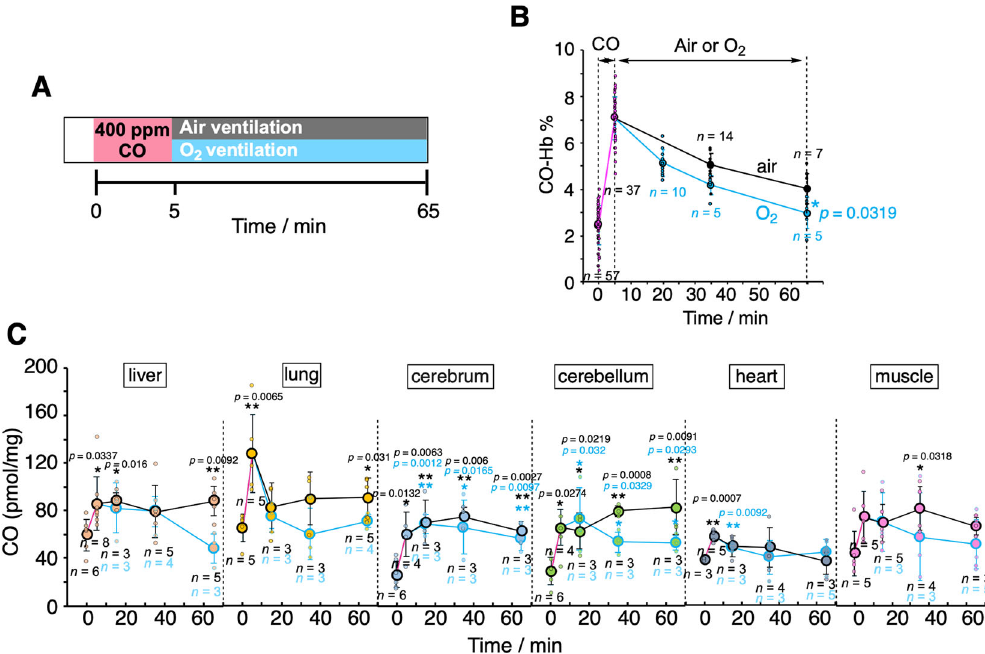
Fig. 6 Effect of normobaric air/O 2 ventilation on CO levels in blood and tissues after exposure to CO in rats. A Anesthetized rats were exposed to CO inhalation (400 ppm) for 5 min followed by either air (black) or O 2 ventilation (blue) as indicated. B Changes in CO-Hb (%) in the venous blood collected from right ventricles as a function of time. Each plot represents mean ± SD ( n > 5, the number of experiments is shown in the panel). Statistical signi fi cance, * p < 0.05, versus air ventilation. C Amounts of CO measured under the experimental conditions described in A . The plots connected by black and blue lines represent the data obtained under air and O 2 ventilation, respectively. Each bar represents mean ± SD ( n > 3, the number of experiments is shown in the panel). Statistical signi fi cance, * p < 0.05, ** p < 0.01; n.s. not signi fi cant versus t =